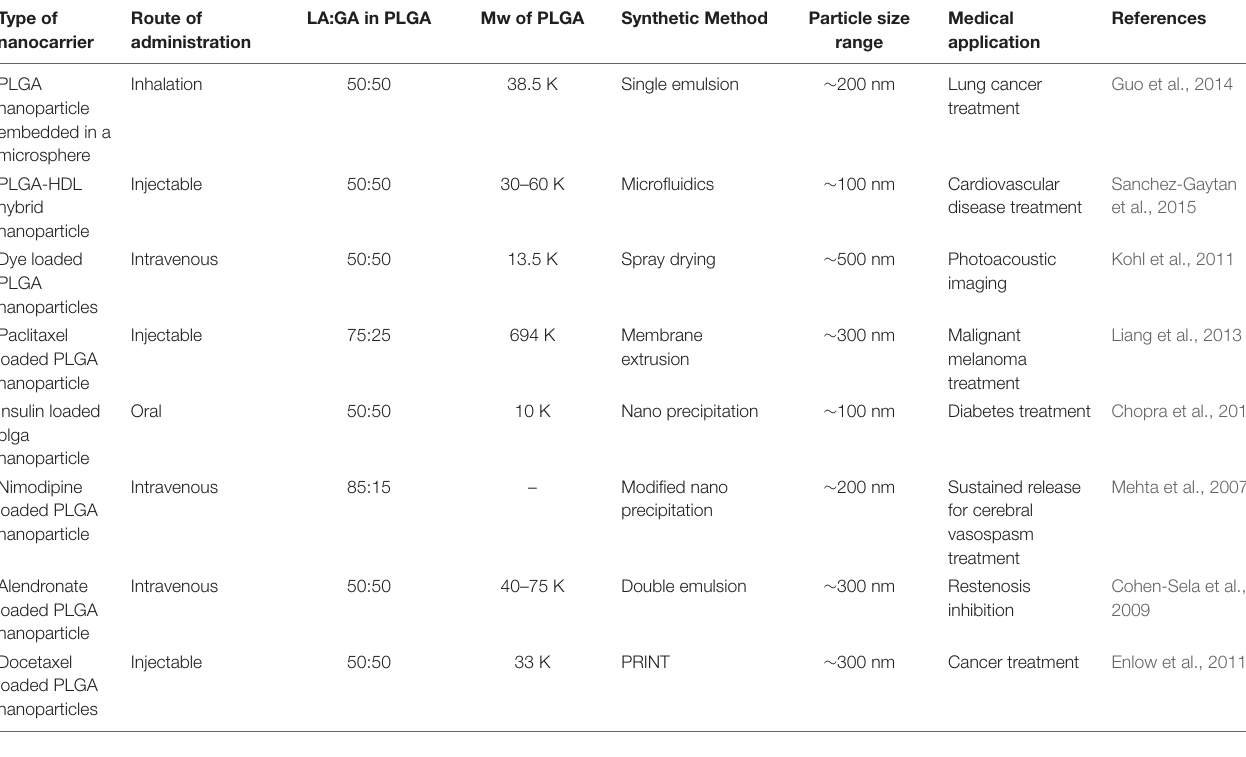
TABLE 1 | Properties of some prepared PLGA nanocarriers, their methods of formation and biological targets.